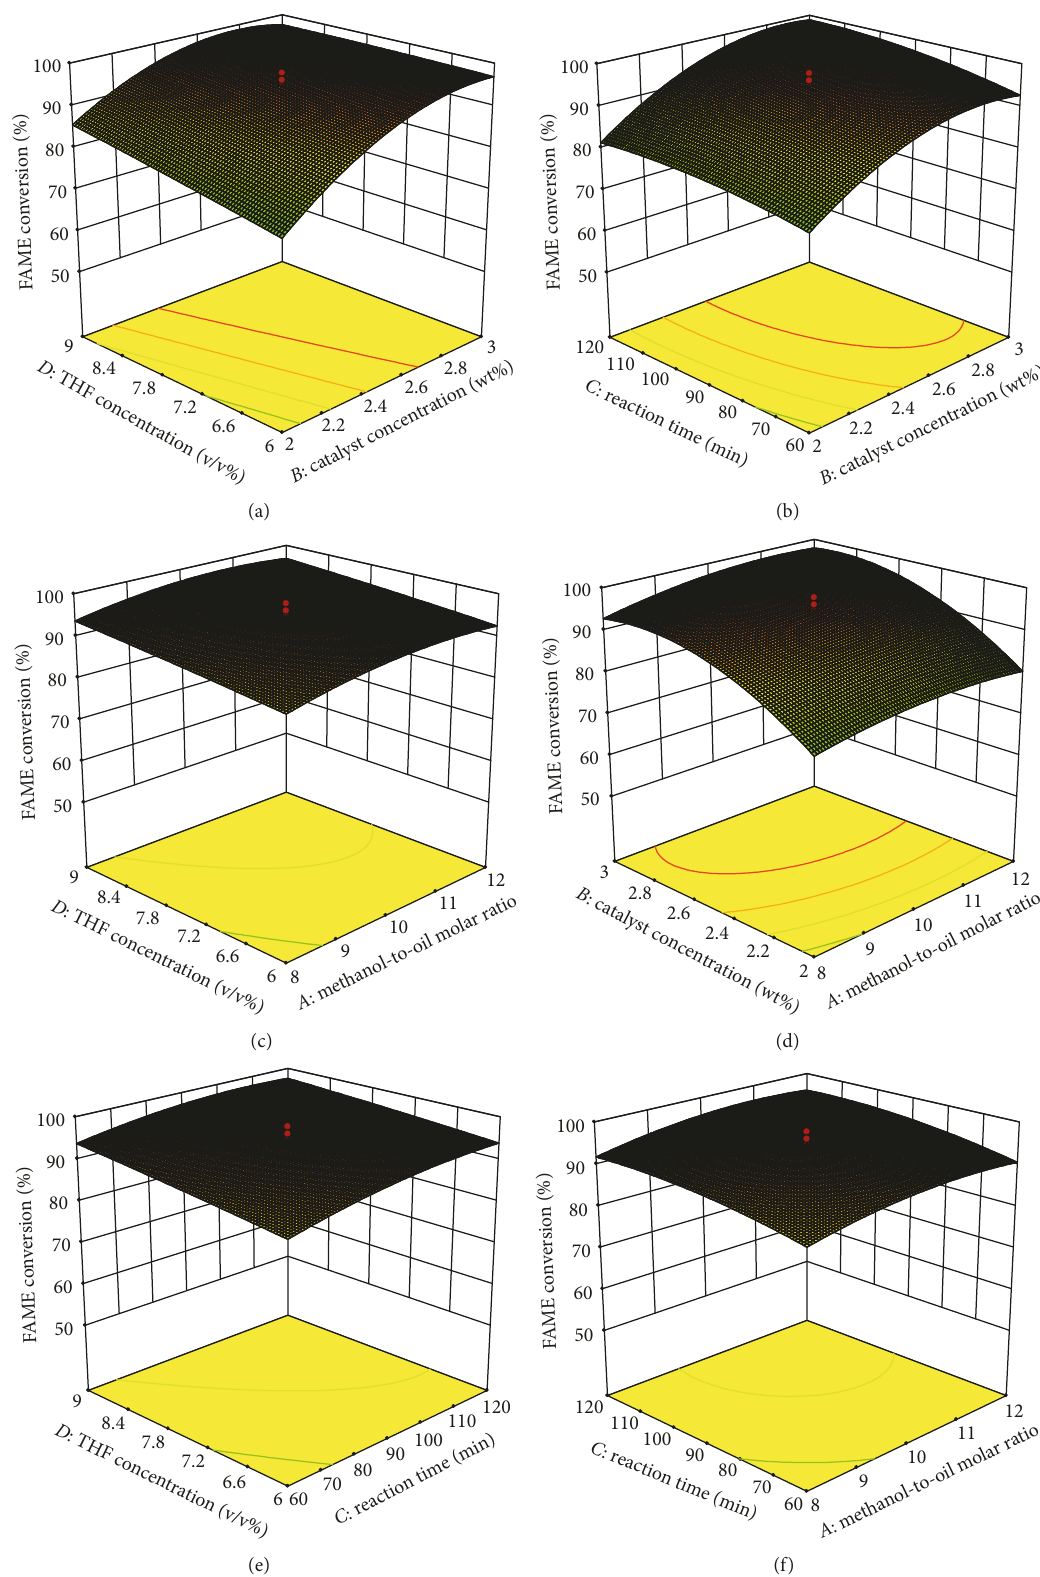
Figure 5: Response surface plots elucidating the effects of (a) THF in methanol concentration and catalyst concentration; (b) reaction time and catalyst concentration; (c) THF in methanol concentration and methanol-to-oil molar ratio; (d) catalyst concentration and methanol- to-oil molar ratio; (e) THF in methanol concentration and reaction time; and (f) reaction time and methanol-to-oil molar